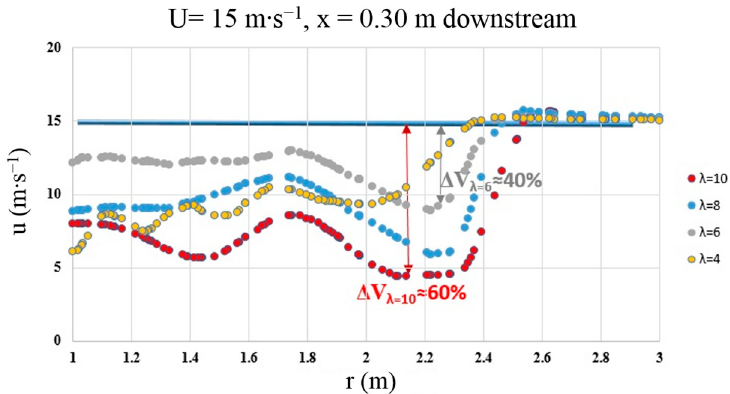
Figure 11. Axial Velocity profile for a radial traverse, and several TSR values.